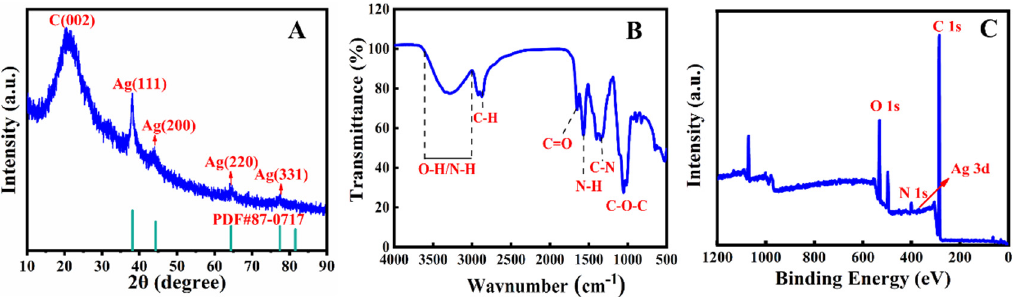
Figure 2. ( A ) XRD spectrum of the AgNPs/N-CQDs composite. ( B ) FTIR spectrum of the AgNPs/N- CQDs composite. ( C ) Full XPS spectrum of the AgNPs/N-CQDs.